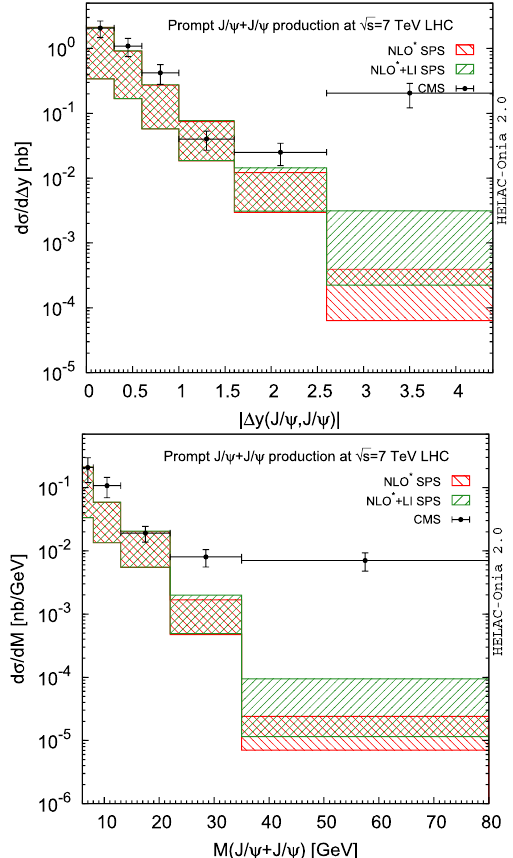
Fig. 1 Rapidity gap | Δ y ( J /ψ, J /ψ) | (left) and invariant mass M ( J /ψ + J /ψ) (right) distributions for di- J /ψ production in CSM √ s = 7 TeV acceptance via SPS within CMS